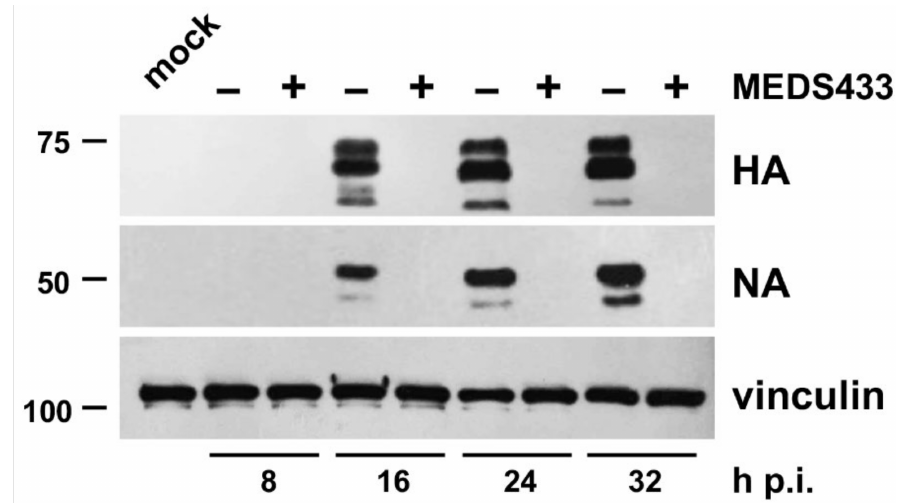
Figure 3. MEDS433 impairs the expression of IAV HA and NA proteins. MDCK cells were infected with IAV at an MOI of 0.1 PFU/cell and, where indicated, treated with 0.5 µ M MEDS433 or DMSO as a control. Total cell protein extracts were prepared at the indicated times p.i., fractionated by 8% SDS-PAGE, and analyzed by immunoblotting with anti-IAV HA and anti-IAV NA pAbs. Vinculin immunodetection was used as a control for protein loading. Molecular weight markers are shown at the left side of each panel.